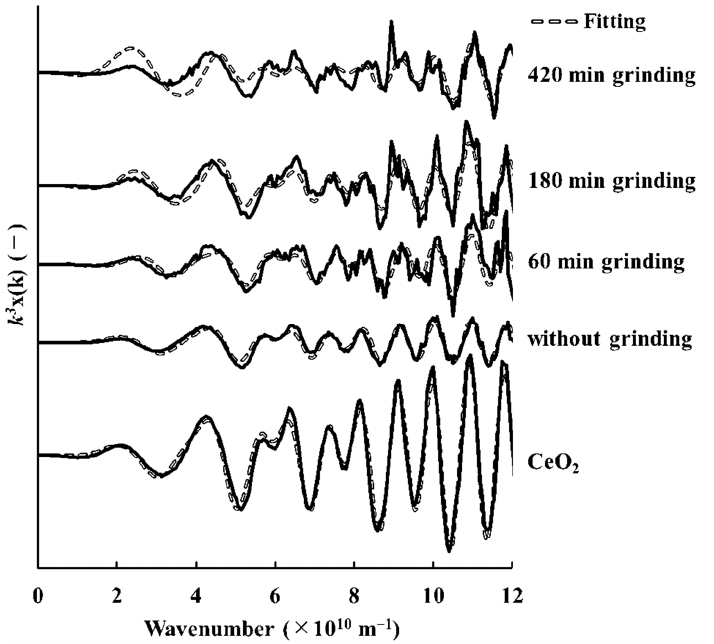
Figure 4. The k 3 -weighted cerium K-edge extended X-ray absorption fine structure spectra of tetravalent cerium oxide, samples by grinding with microwave irradiation.